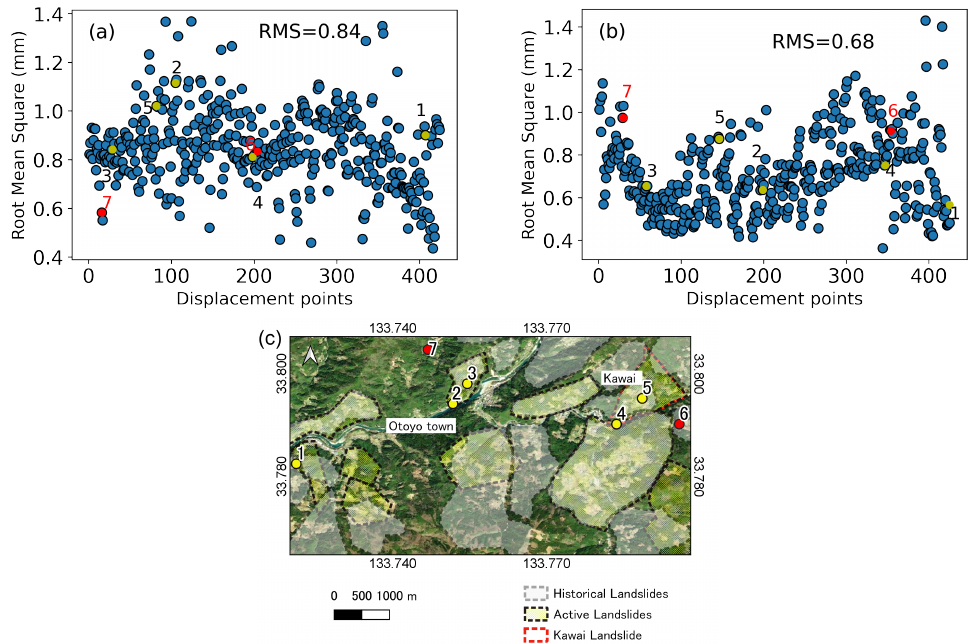
Figure 12. Comparison of the root mean square (RMS) before ( a ) and after the application of the RF mask ( b ) derived from the uncertainty estimate for the SBAS velocity from a linear regression. ( c ) The majority of the RMS values at active landslide boundaries (yellow hashed polygons) decreased by 0.3 mm in Otoyo Town (yellow dots), while a few points located in the stable zones (red dots) had increased RMS values after the application of the RF